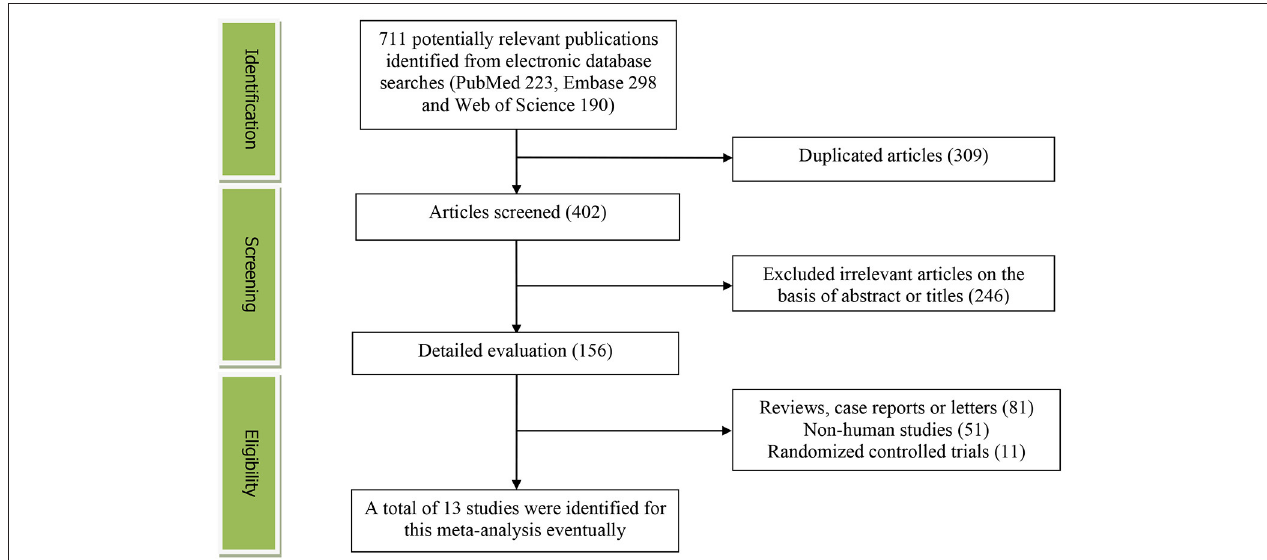
FIGURE 1 | The detailed flow diagram of the study identification and selection in this